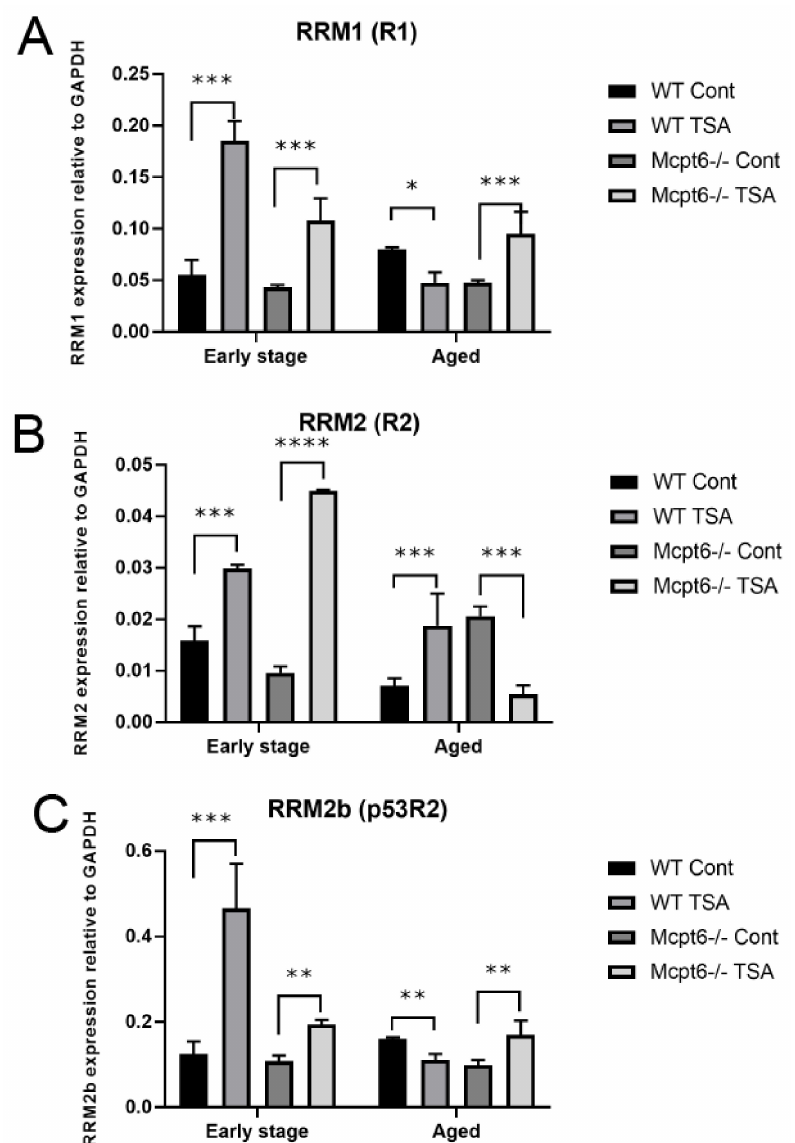
Figure 5. The absence of tryptase Mcpt6 causes dysregulated expression of the R1, R2, and p53R2 subunits of ribonucleotide reductase (RNR) in MCs exposed to TSA. WT and Mcpt6 − / − MCs (early stage and aged) were cultured ± TSA (see legend to Figure 2). Total RNA was isolated and was subjected to qPCR analysis for expression of ( A ) RNR R1 (RRM1 / R1), ( B ) RNR R2 (RRM2 / R2), and ( C ) RNR p53R2 (RRM2b / p53R2). Note that the e ff ects of TSA on gene expression were similar in early stage WT vs. Mcpt6 − / − MCs, whereas contrasting e ff ects of TSA on the regulation of RRM1, RRM2, and RRM2b were seen in aged WT vs. Mcpt6 − / − MCs. Expression of genes was evaluated relative to GAPDH. Data are presented as mean values ± SEM, pooled from three di ff erent experiments, analyzed with Sidaks multiple comparison test or by Two-way ANOVA. *** p ≤ 0.001, ** p < 0.005. Cont, vehicle